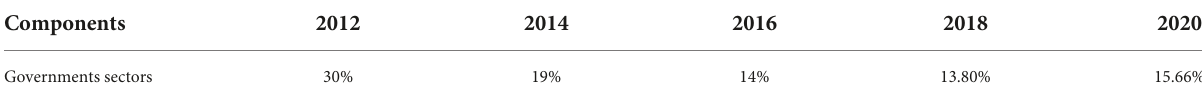
TABLE 2 Readiness of technological infrastructure in government sectors (during